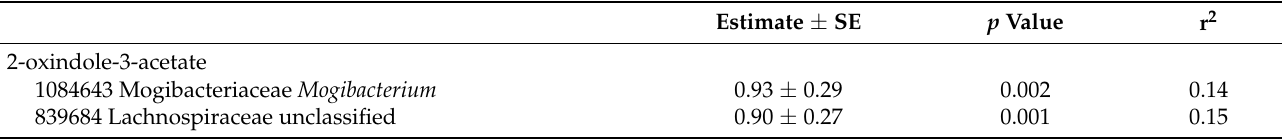
Table 8. Correlations between plasma indoles and